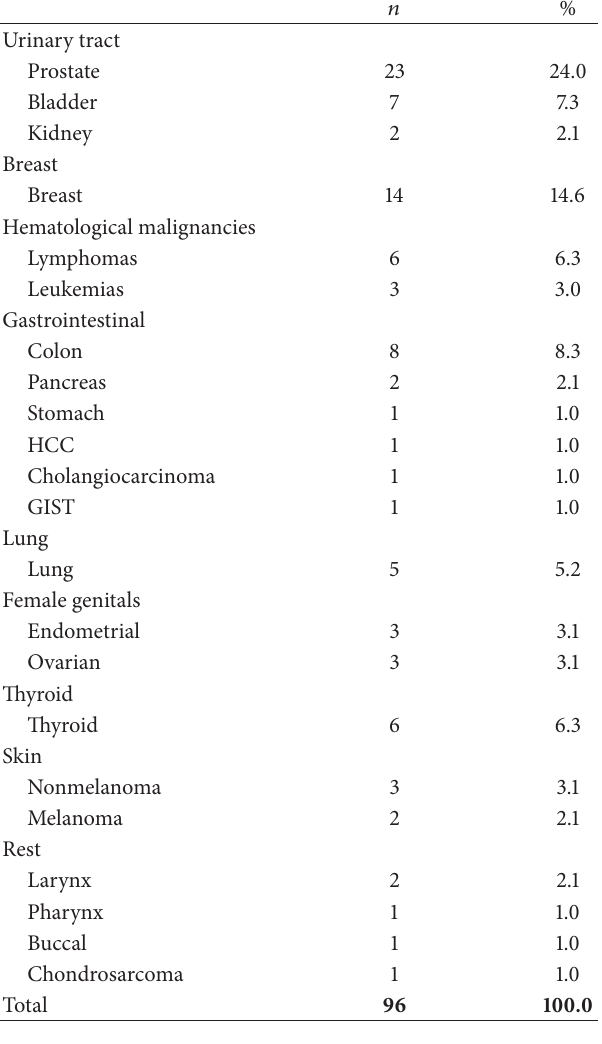
Table 2: Types of cancer in subjects with T2DM regularly followed